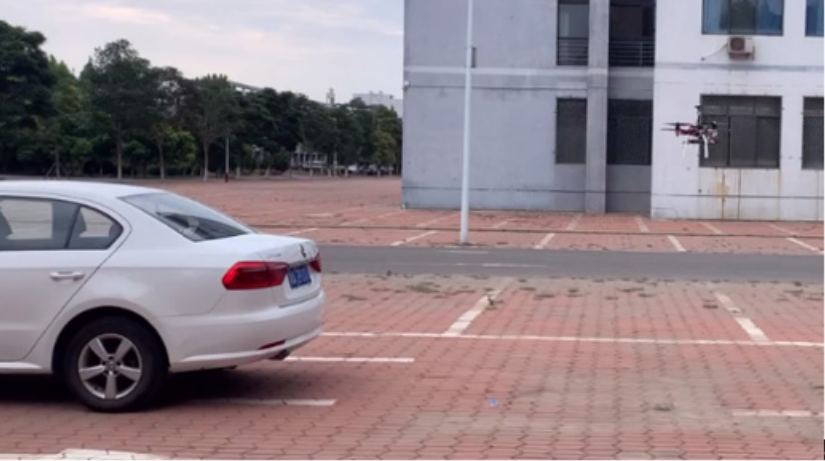
Figure 22. UAV pollution point detection experiment.